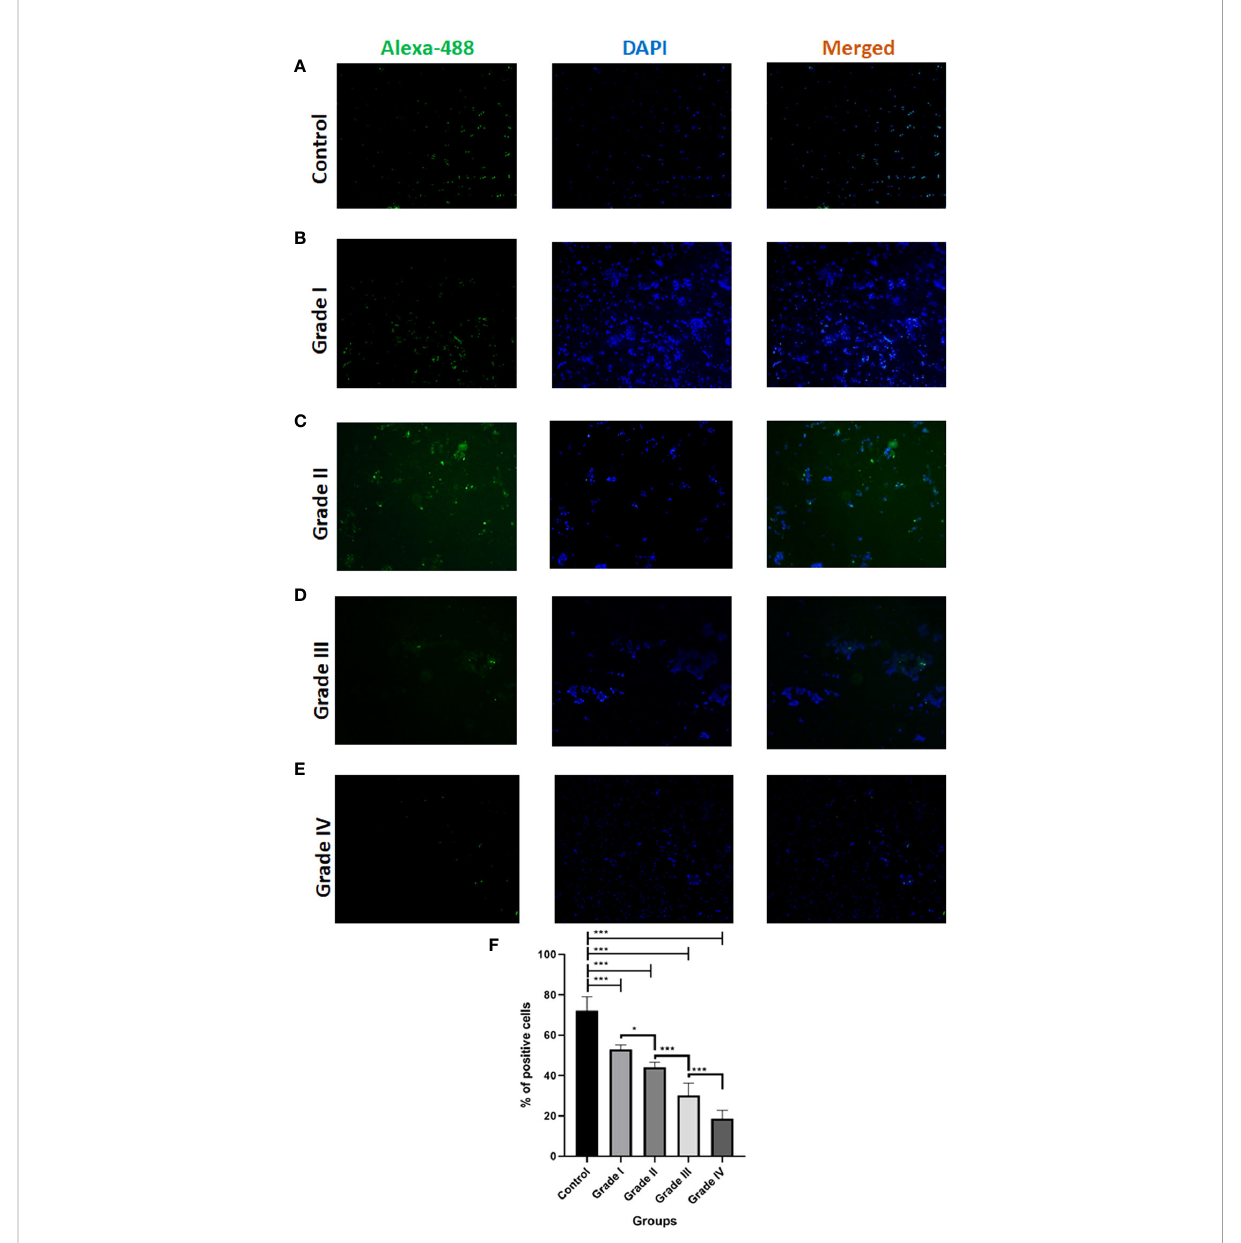
FIGURE 4 Immunocytochemistry analysis of Cytochrome C in different grades of glioma in comparison to control. (A-E) Representative fl uorescent microscopic images depict the expression of apoptotic protein Cytochrome C along with nuclear dye DAPI expression in different grades of Glioma. (F) Graph represents the total % of Cytochrome C positive cells. n=6 per group. A value of *p < 0.05, ***p <